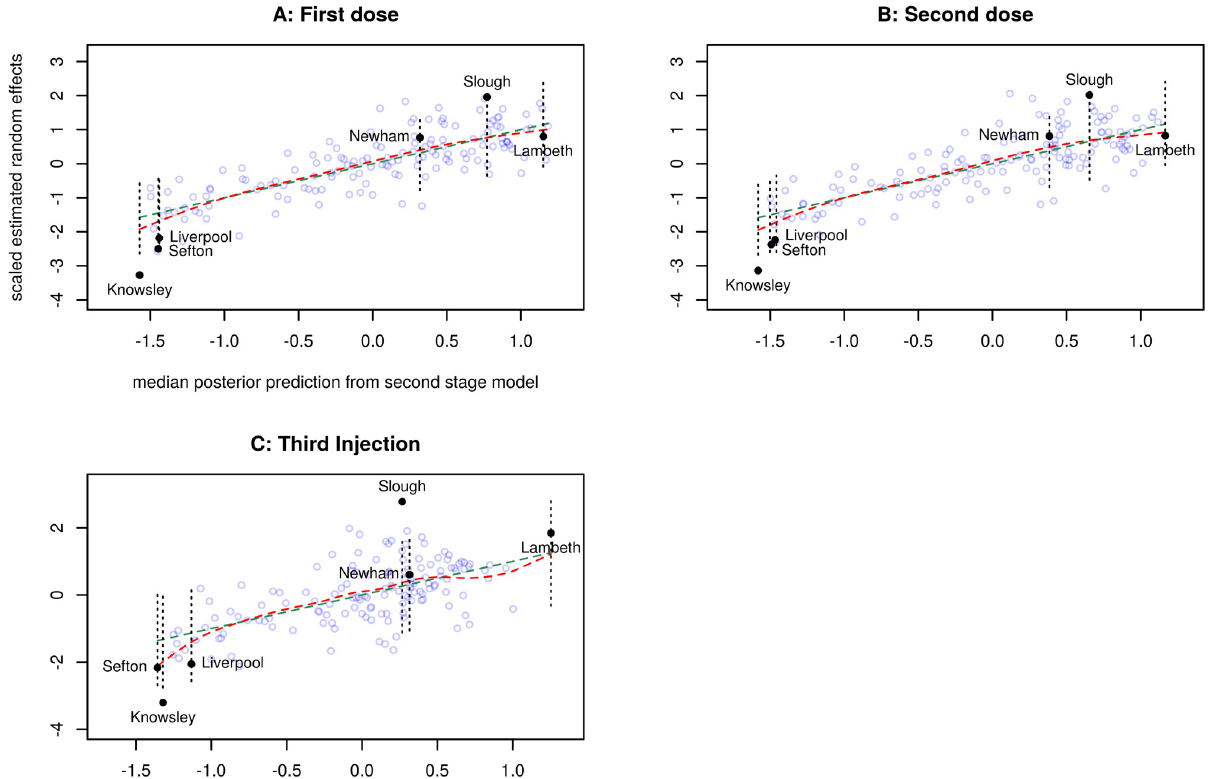
Fig 5. Second stage prediction of scaled estimated random effects from model D . For each vaccination, the corresponding panel shows the scaled estimated random effects c against the median posterior predictive values from the second stage model. The dashed green line shows the predictions, i and the dashed red line shows a smooth spline through the c i . Points marked • are selected Upper Tier Local Authorities mentioned elsewhere in the text. For these points, the vertical dotted lines show the 90% credible interval of posterior predictive